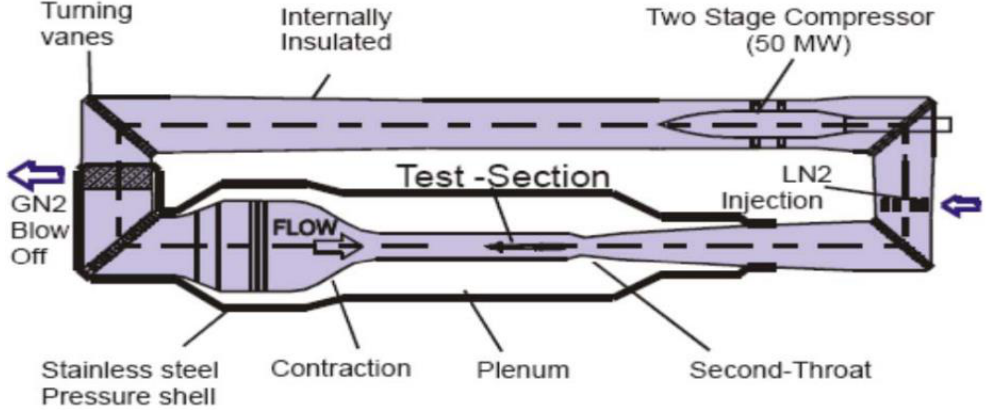
Figure 1. Aerodynamic circuit sketch of the ETW facility.